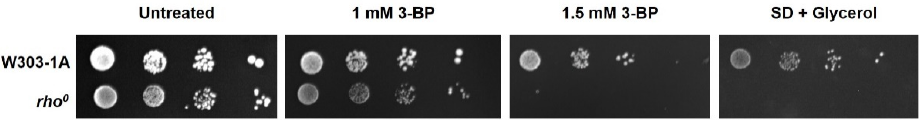
Figure 2. rho 0 mutants exhibit increased sensitivity to 3 ‐ BP. Spot tests were performed to test the sensitivity of rho 0 and WT strain to 3 ‐ BP. Serial dilutions of strains were spotted on SD medium plates with different 3 ‐ BP concentrations and incubated for 2 days at 30 °C.